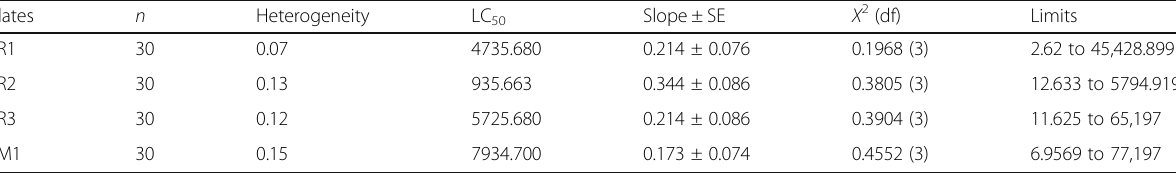
Table 1 LC 50 estimates of different Beauveria bassiana isolates from bioassays against second-instar larvae of Spodoptera litura Isolates n Heterogeneity LC